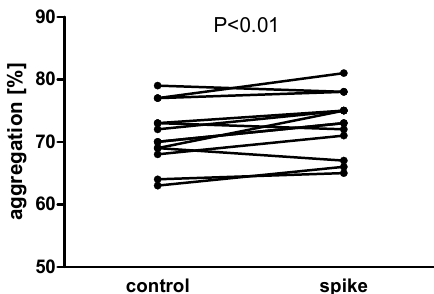
Figure 6. Collagen-induced aggregation of isolated platelets in the presence of the spike protein. The spike protein significantly increased platelet aggregation compared to the control ( p < 0.01; n = 13). The statistical significance of differences between control vs. spike sample was estimated with the bootstrap-boosted paired Student’s t -test. To investigate a potential mechanism underlying the spike protein–blood platelet in- teractions, we analyzed the role of GPIb and the binding of vWF to platelets in the pres- ence of spike protein.